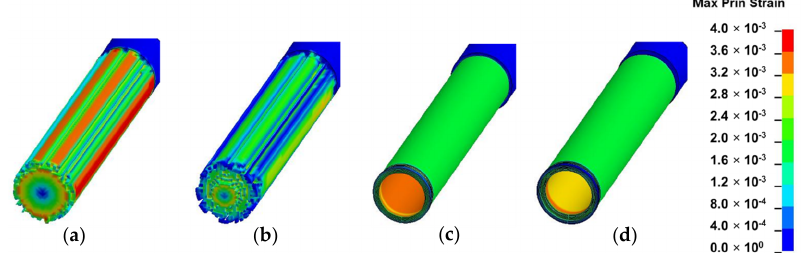
Figure 12. Fringe plots of maximum principal strain of: ( a ) solid-homogeneous; ( b ) solid-inhomogeneous; ( c ) hollow-homogeneous and ( d ) hollow-inhomogeneous models in torsion mode.